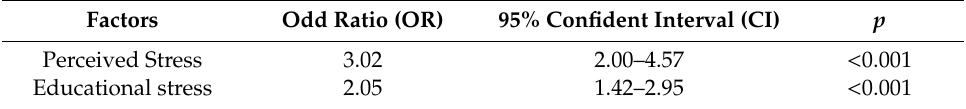
Table 2. Relations between the presence of bruxism and perceived stress, educational stress.